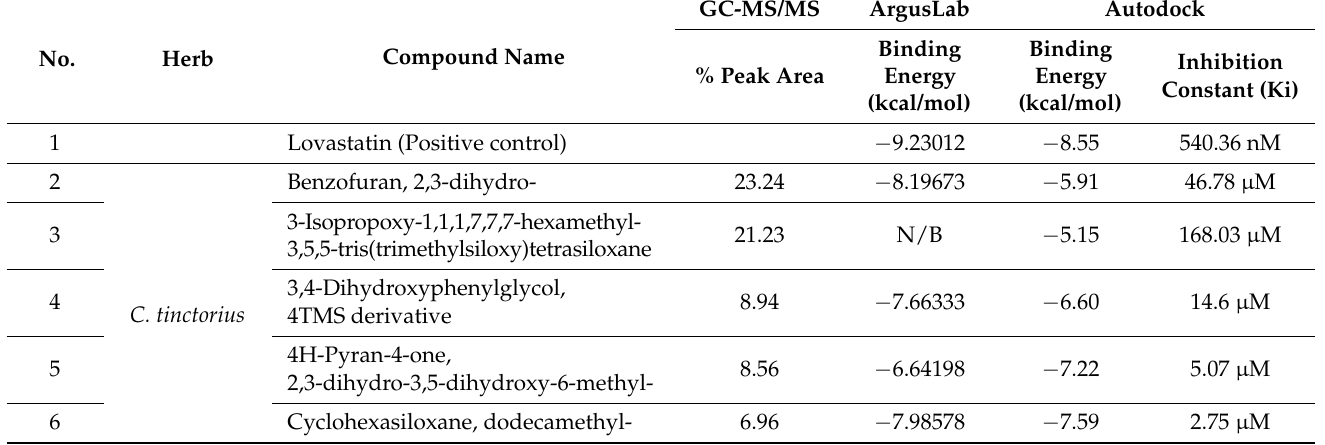
Table 13. Energy binding and phytochemical inhibition constants of herbal extracts with water at the binding sites of HMGR from ArgusLab and Autodock analysis and quantification of each compound through GC-MS/MS